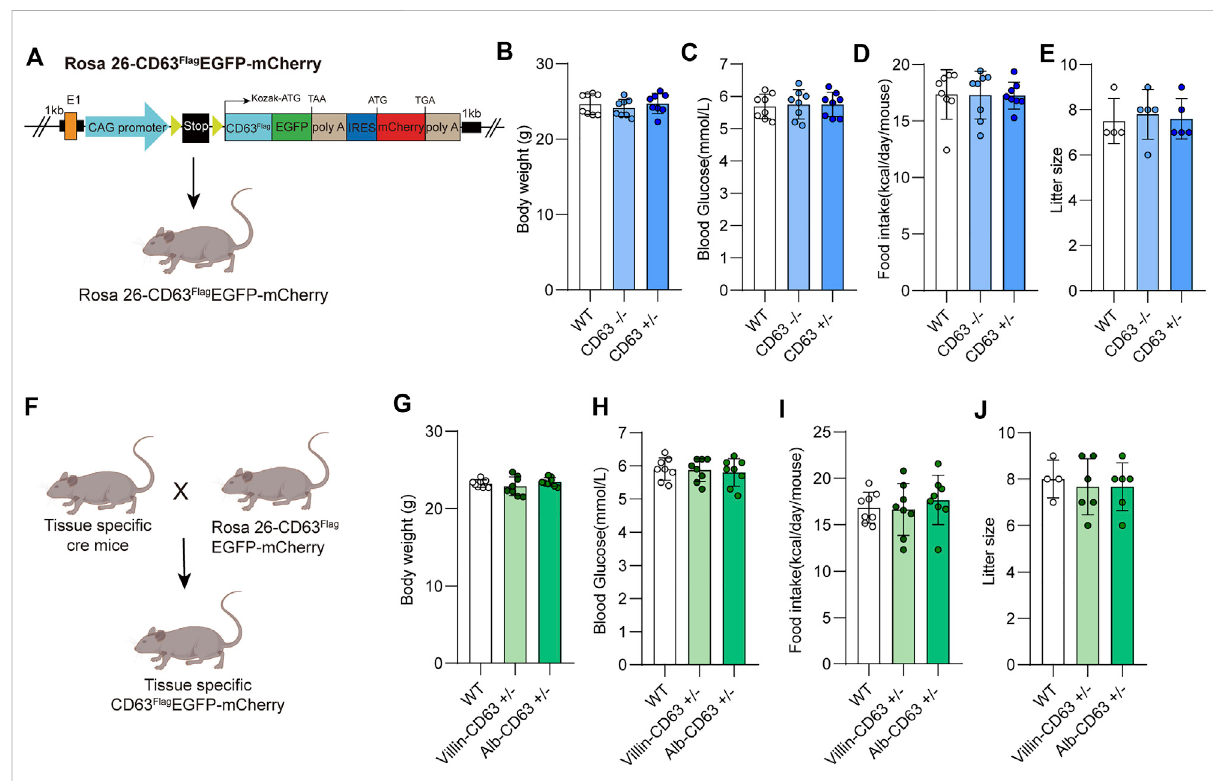
FIGURE 1 Construction and physiological assessment of tissue speci fi c EV tracing and screening mice model. (A) Schematic representation of Rosa26- CD63 Flag EGFP-mCherry KImouse ’ sconstruction. (B – E) Measurementsofthebodyweight andbloodglucose,food intake, littersize fromwild-type, CD63 Flag EGFP-mCherry mouse (WT: wild-type; CD63: CD63 Flag EGFP-mCherry) ( n = 8 for each group). (F) Schematic representation of rosa26- CD63 Flag EGFP-mCherry KI mouse crossed with tissue speci fi c Cre mouse to generate tissue speci fi c CD63 Flag EGFP-mCherry mouse. (G – J) Physiological indicators of tissue speci fi c CD63 Flag EGFP-mCherry mice. Measurement of body weight, blood glucose, food intake, and litter size of wild-type and tissue-speci fi c CD63 Flag EGFP-mCherry mice (WT: wild-type; Alb-CD63: Alb- CD63 Flag EGFP-mCherry; Vill-CD63: Villin- CD63 Flag EGFP-mCherry). ( n = 8 for each group). Data indicate the mean ±